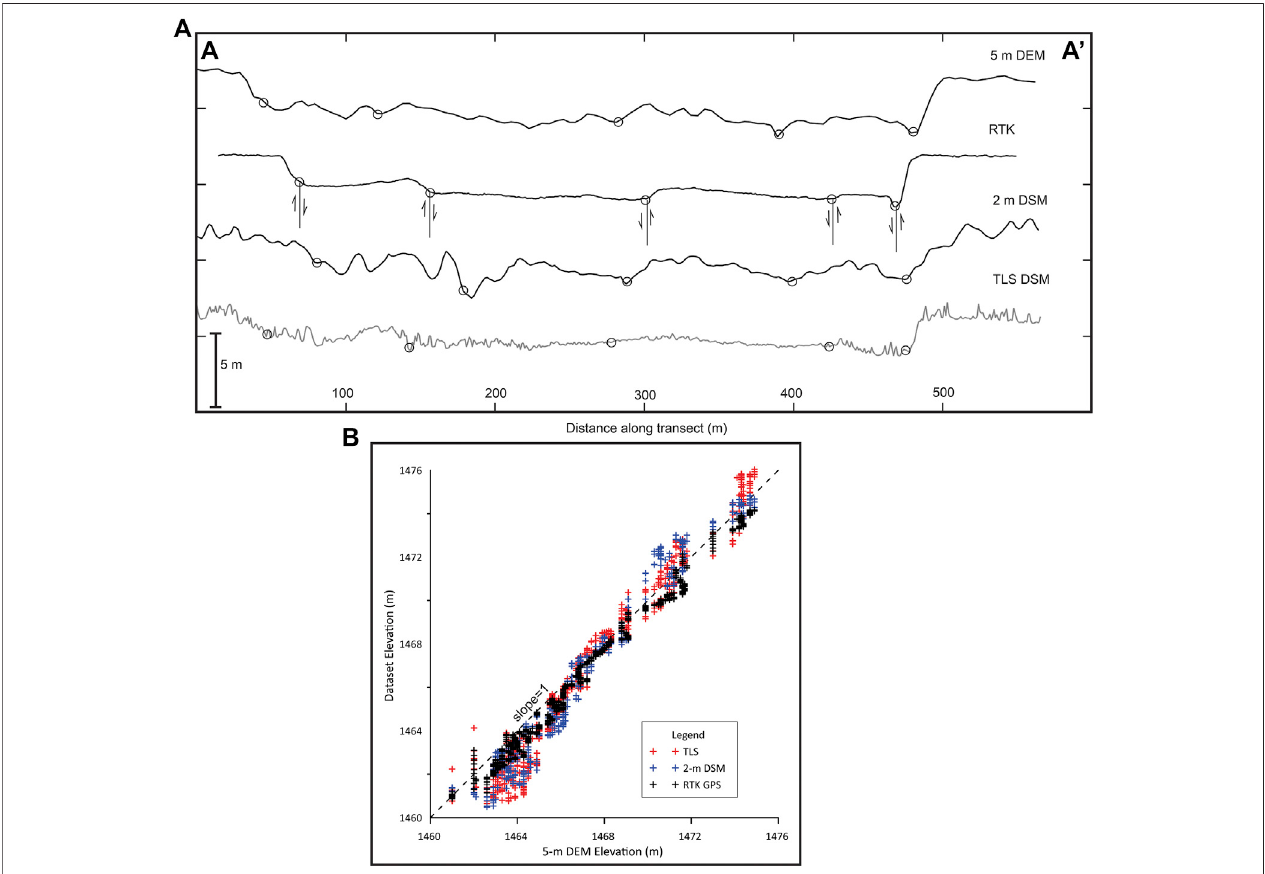
FIGURE 6 | (A) Detrended topographic pro fi le A-A ’ ( Figure 5 ) from all elevation datasets at the cross-cutting faults shown in Figure 5 and (B) a comparison of unadjustedelevationstoelevationsinthe5-mDEM.Verticalexaggerationin (A) is10x.Circlesin (A) indicatethelocationsofmappedfaulttraces.Alldatasetsroughlyfollowa trend line with slope (cid:2) 1, indicating negligible non-linear distortions over this small area. TLS and 2-m DSM datasets exhibit larger scatter, which is partially due to the lack of vegetation fi ltering.